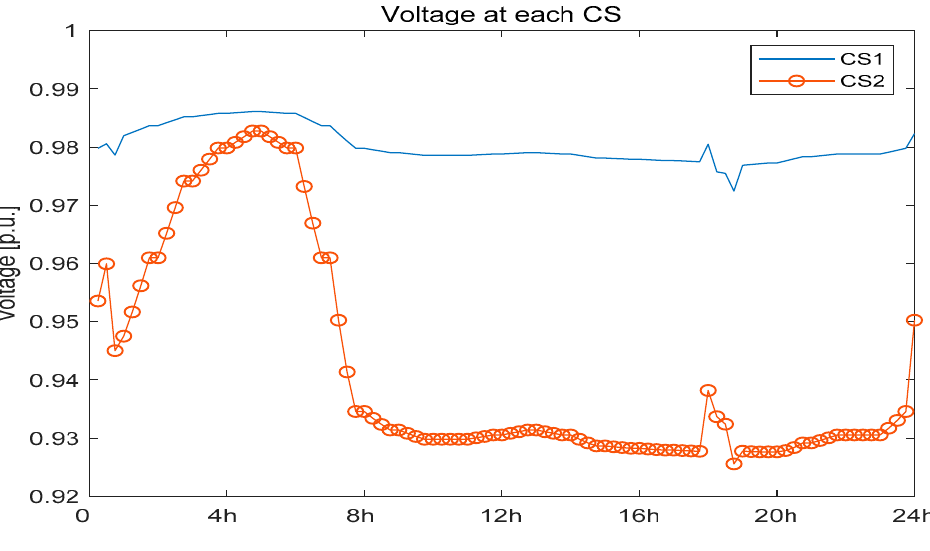
Figure 9. Voltage of CSs in Case 1.